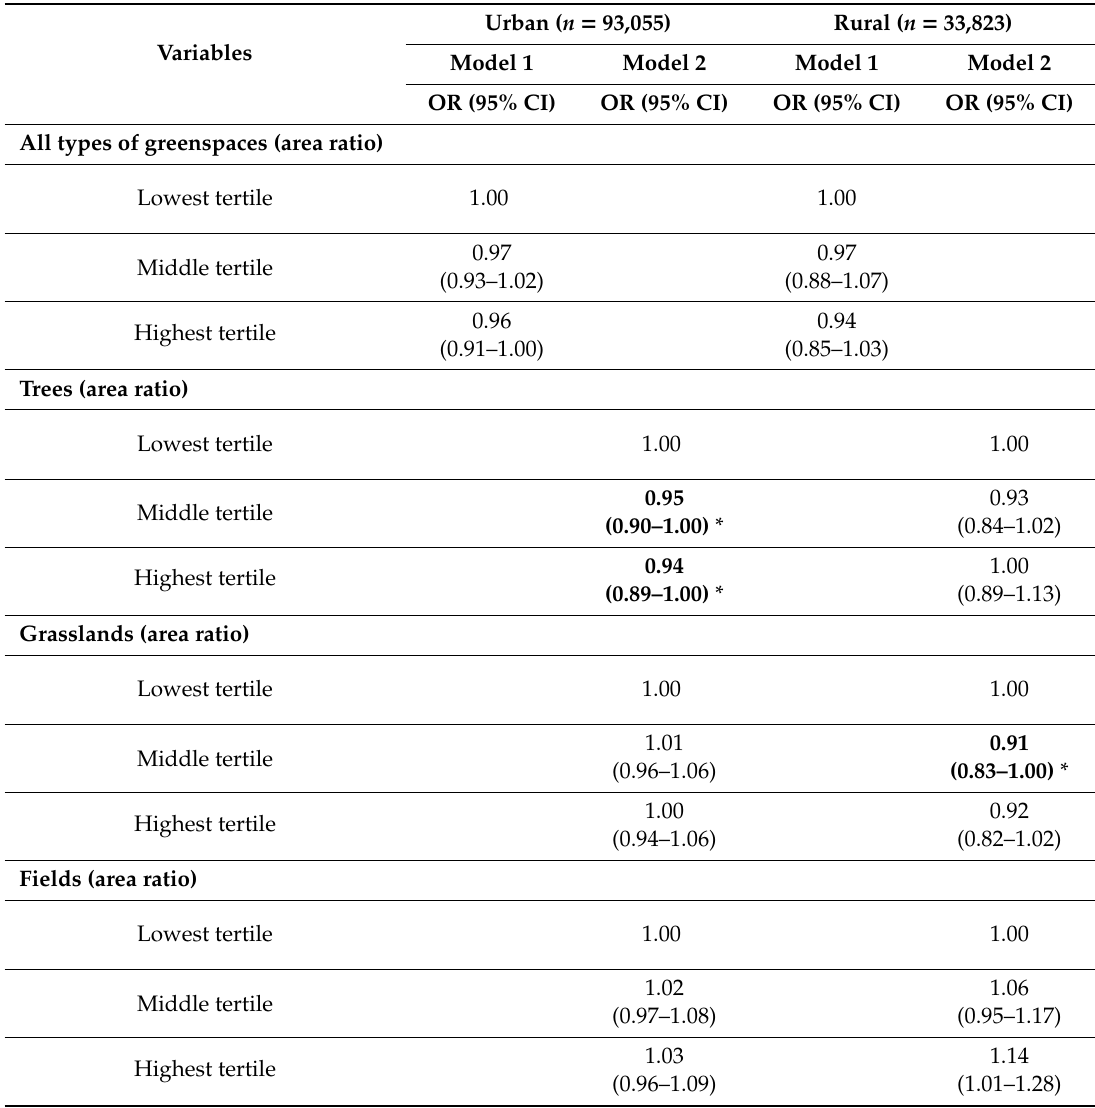
Table 4. Odds ratios (ORs) with 95% confidence intervals (95% CIs) for the association of greenspace and depression among older Japanese